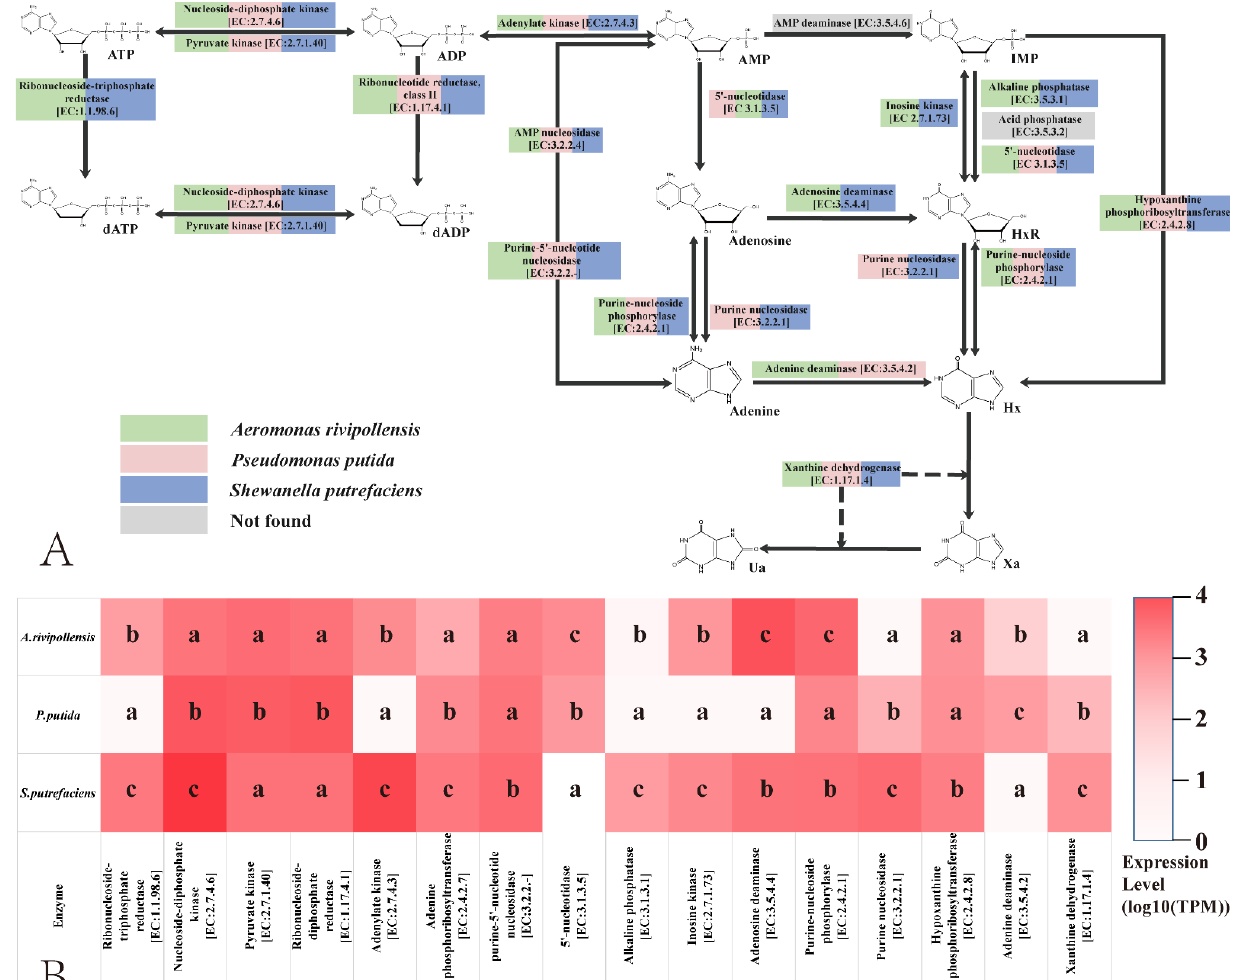
Figure 2. Microbial contributions in degrading purine nucleotide compounds. ( A ) Purine nucleotide compounds pathways in grass carp juice induced by specific spoilage bacteria against the GO and KEGG database. ( B ) Gene expression analysis of specific spoilage bacteria-induced in grass carp juice revealed by gene transcriptomics results. The same lowercase in a column indicates no significant differences ( p > 0.05).